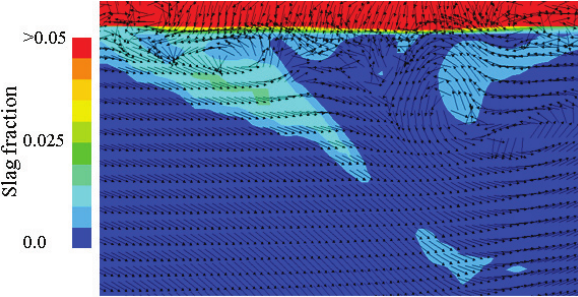
Figure 6. Modeling results showing “ necking and detach- ment ” of slag (light) into the metal bulk (dark)